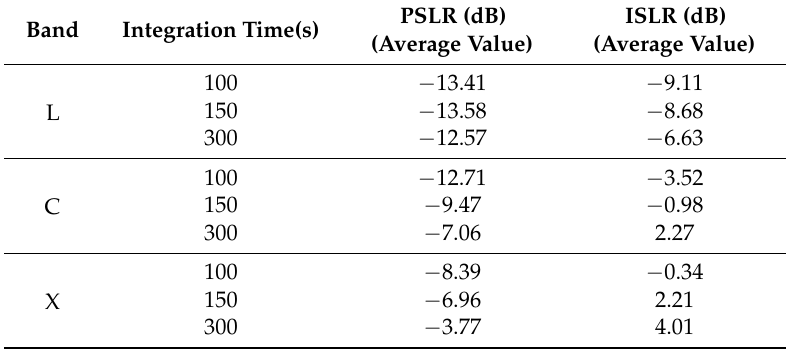
Table A2. Evaluations of point target imaging for different bands and different integration